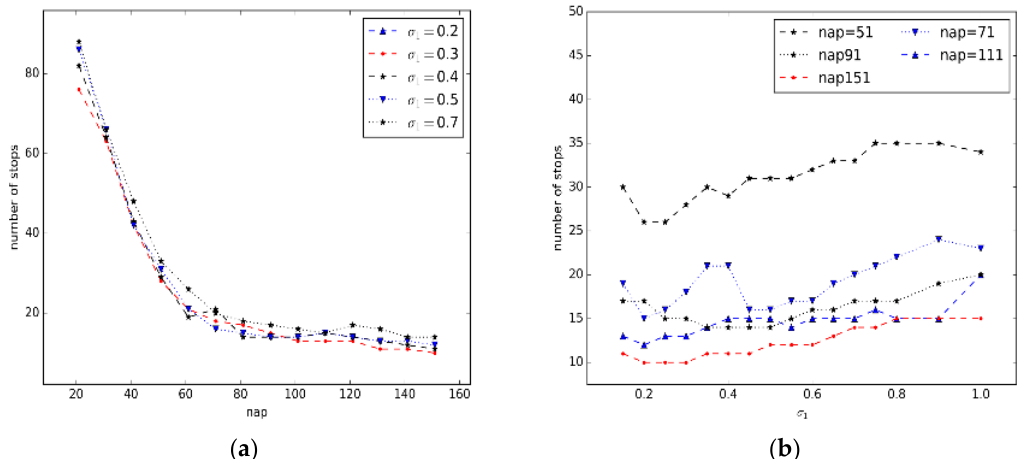
Figure 8. The number of detected stops with different values for parameters Nap and 𝜎 1 . ( a ) The number of stops found for different Nap ; ( b ) the number of stops found for different 𝜎 1 .